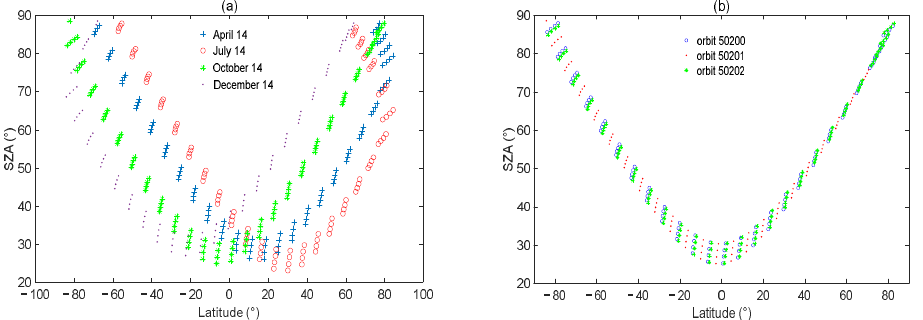
Figure 1. ( a ) Latitude distribution of SZAs on 14 April (blue ‘+’), 14 July (red ‘o’), 14 October (green ‘*’), and 14 December (purple ‘·’) in 2011; ( b ) latitude distribution of the SZAs for orbit 50200 (blue ‘o’), 50201 (red ‘·’), and 50202 (green ‘*’) on 5 October 2011.